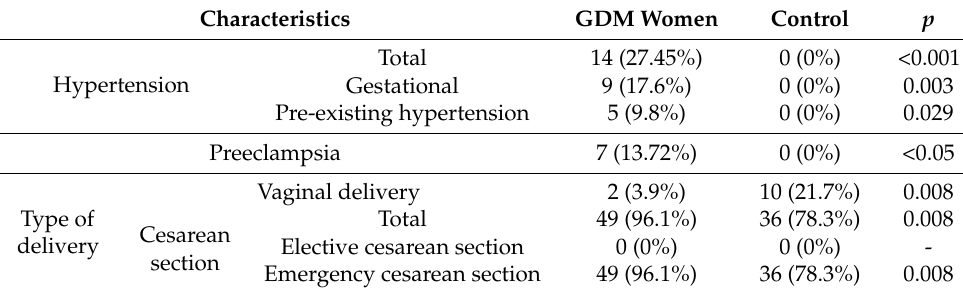
Table 3. Maternal complications associated with